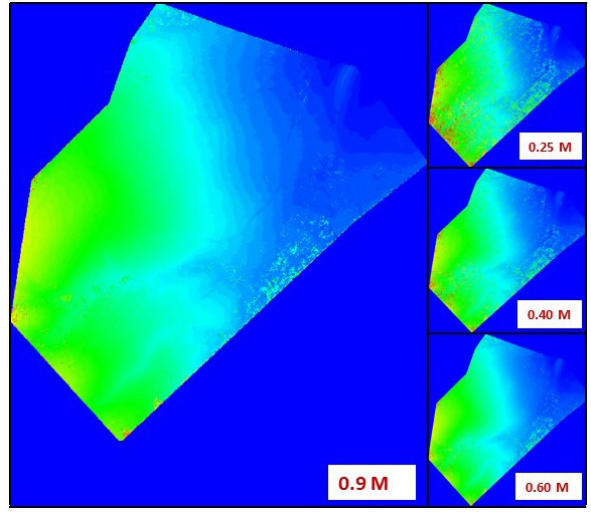
Figure 9: Terrain points at different